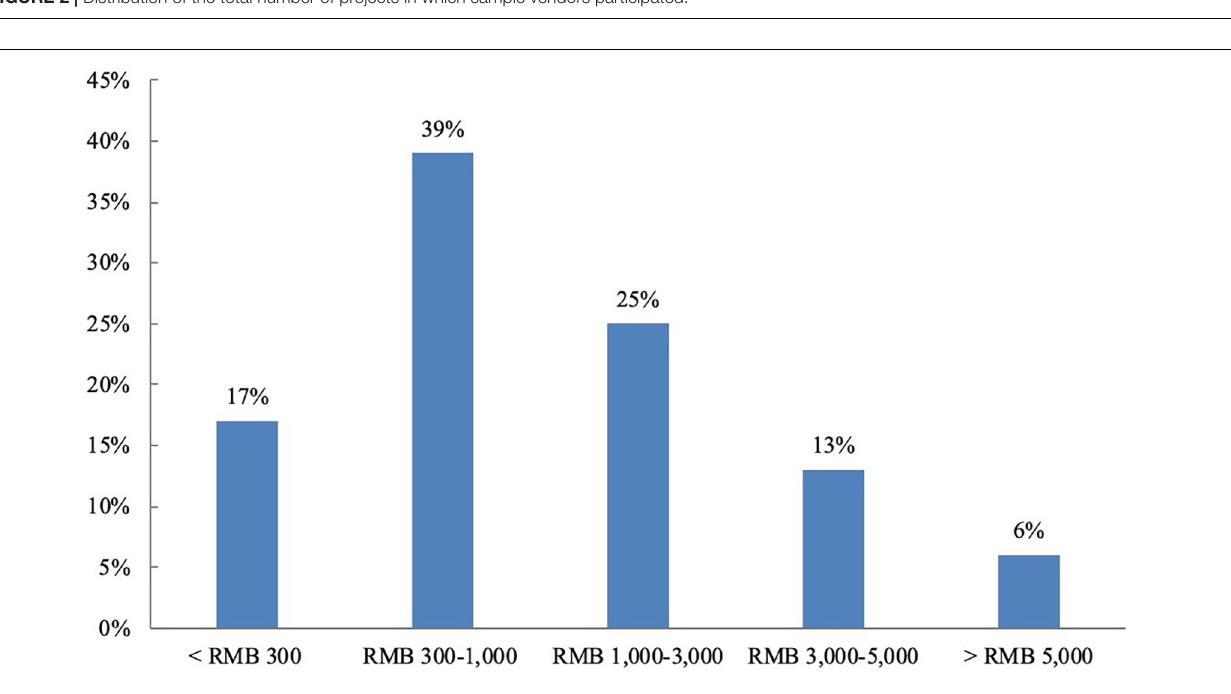
FIGURE 2 | Distribution of the total number of projects in which sample vendors participated.